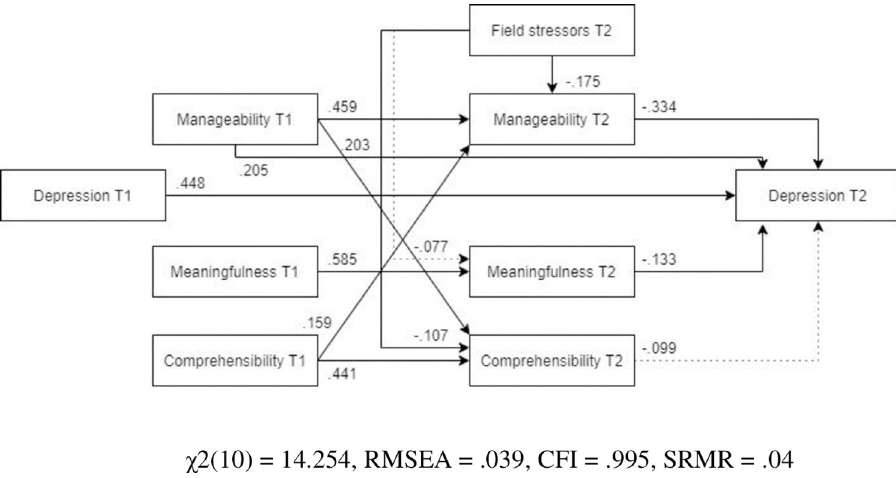
Fig 9. Tested structural equation model for depression—females. χ 2(10) = 14.254, RMSEA = .039, CFI = .995, SRMR =